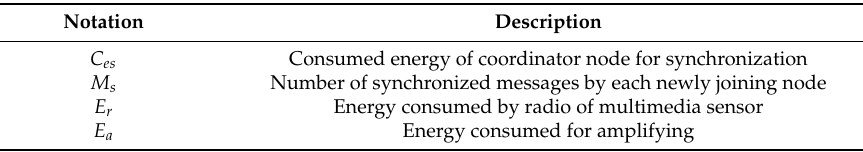
Table 2. Notations used and their